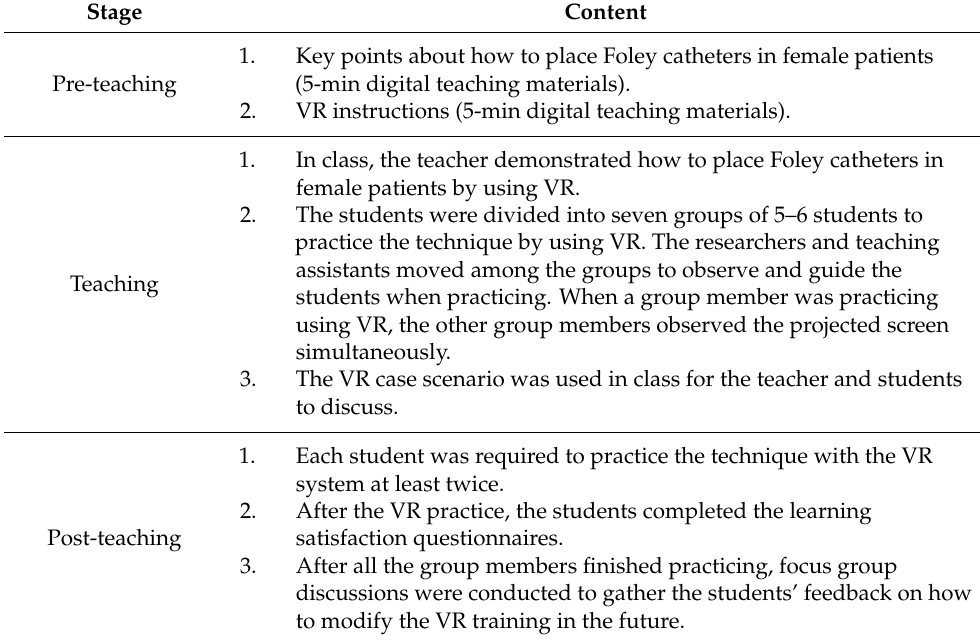
Table 1. Research